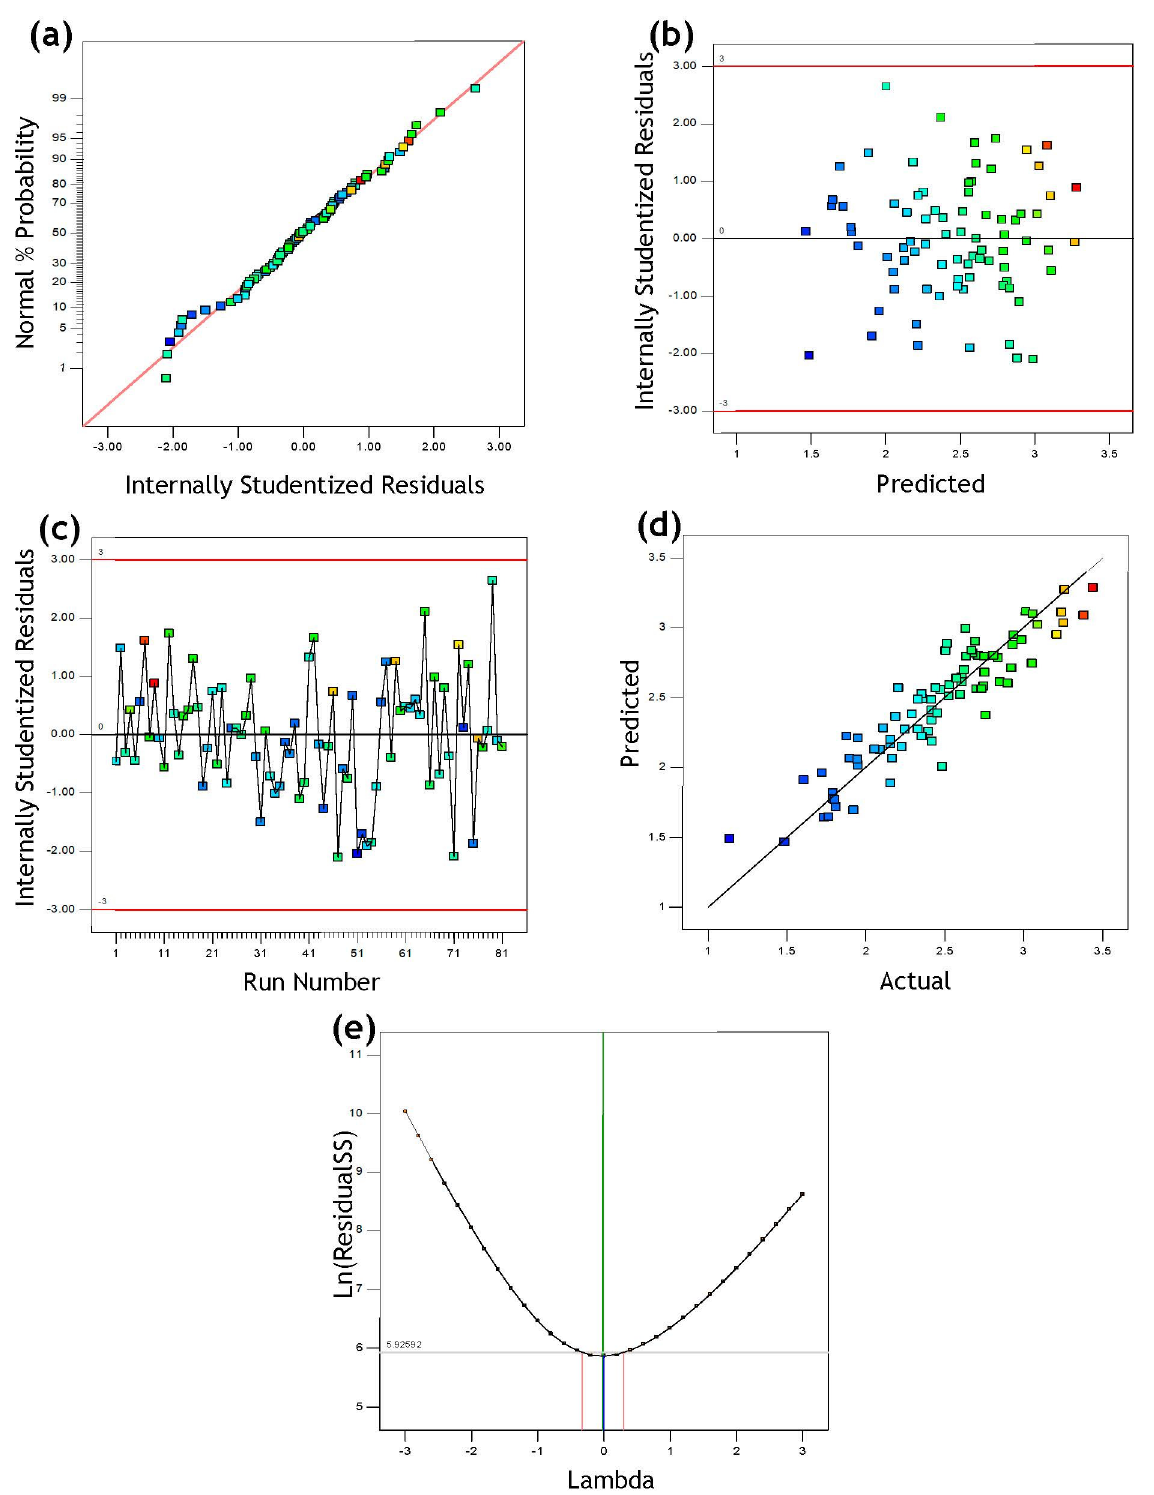
Figure 11. The response model diagnostic plots: ( a ) normal residuals, ( b ) residual vs. predicted, ( c ) residuals vs. run, ( e ) predicted vs. actual, and ( d ) Box-cox.